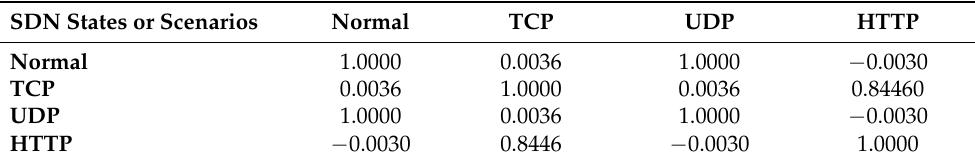
Table 8. Correlation matrix for T p when the SDN is operating normally and subjected to popular variants of DDoS flooding attacks. SDN States or Scenarios Normal TCP